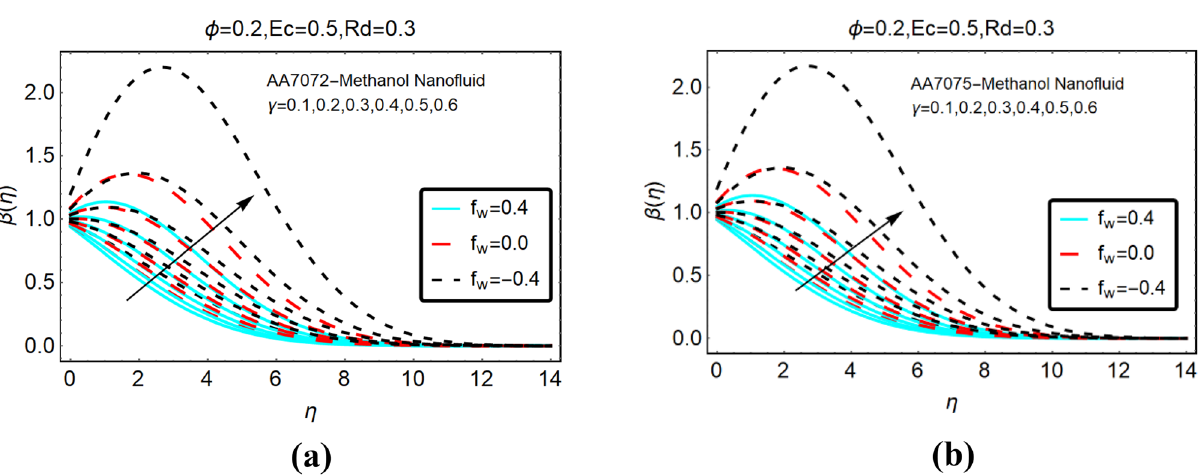
Figure 8. The effects of heat generation on ( a ) AA7072-Methanol ( b )